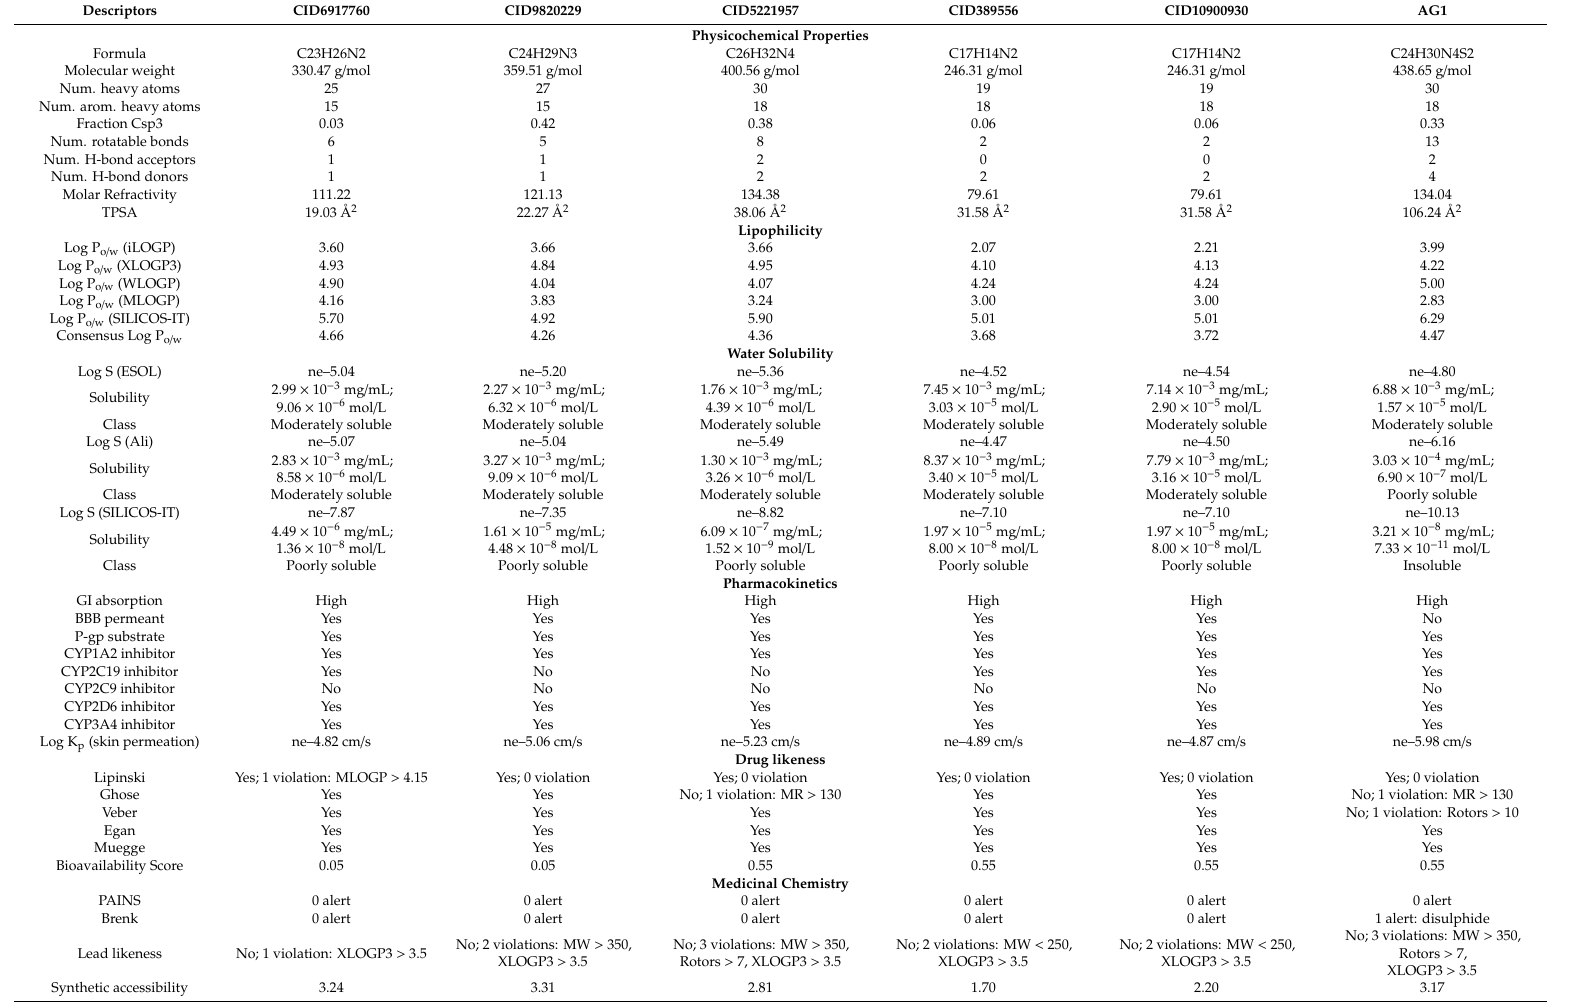
Table 2. Physicochemical properties, lipophilicity, water-solubility, pharmacokinetics, drug-likeness, and medicinal chemistry properties of selected ligands determined by the SwissADME